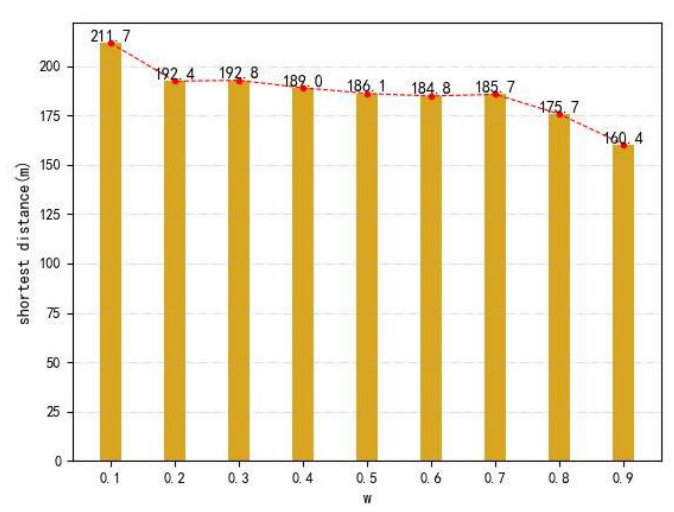
Figure 6. Closest relative distances with different values of 𝑤 .